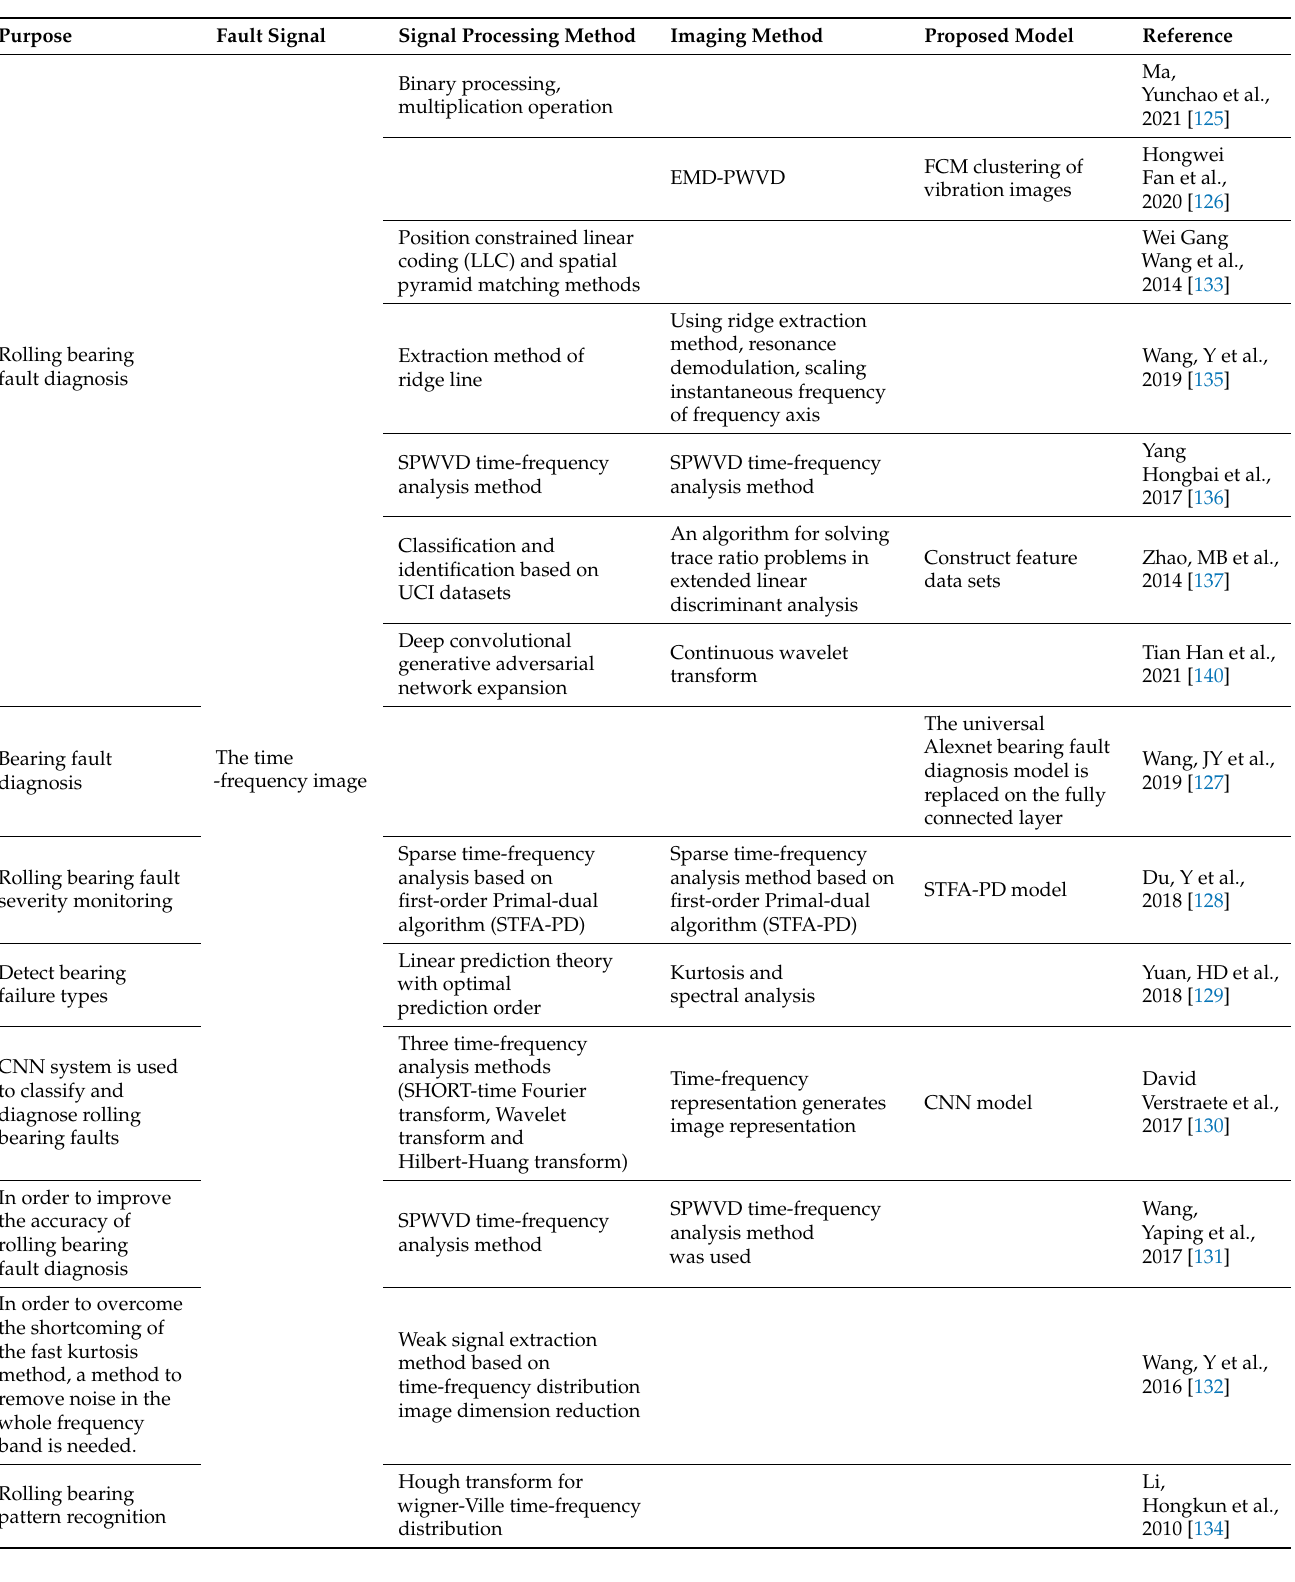
Table 14. Summary and comparison table of time-frequency image